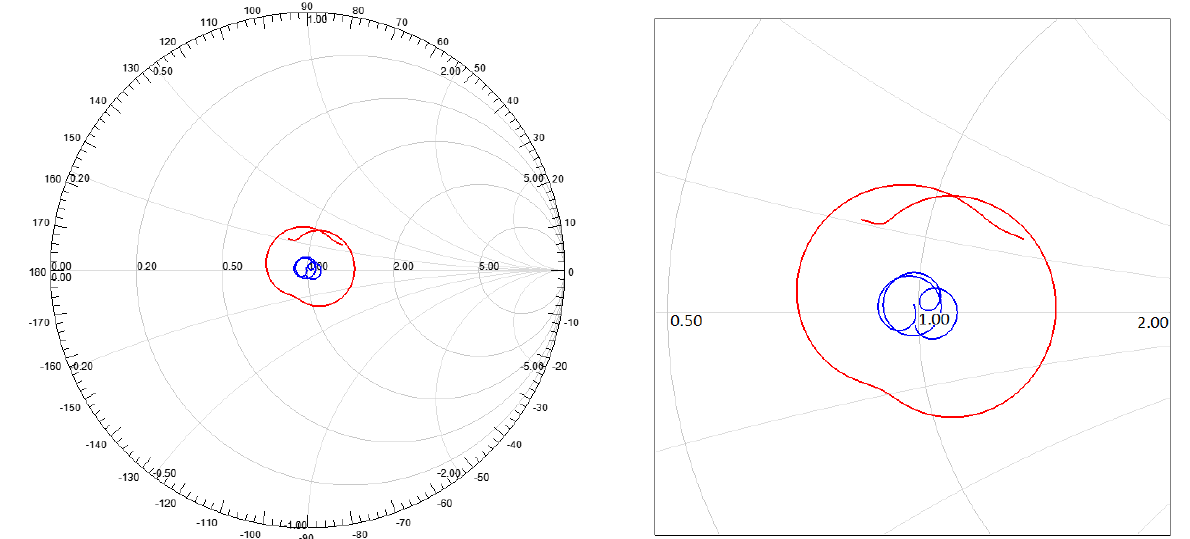
Figure 4. Effect of the air gap in the coaxial cable: the return loss with the air gap (blue line) and without